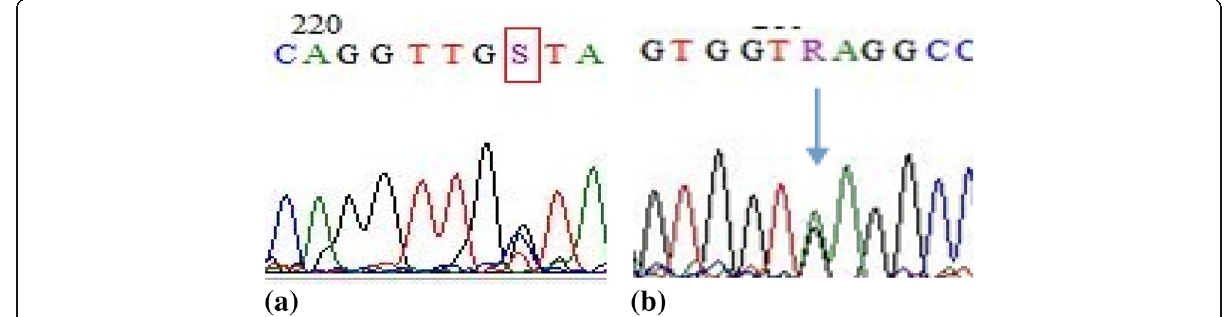
Fig. 2 Sequences from individuals with mutations in the β -globin gene (HBB, NM_000518) at c92+5G>C (IVS1nt5) ( a ) or at c.79G>A (CD-26) ( b